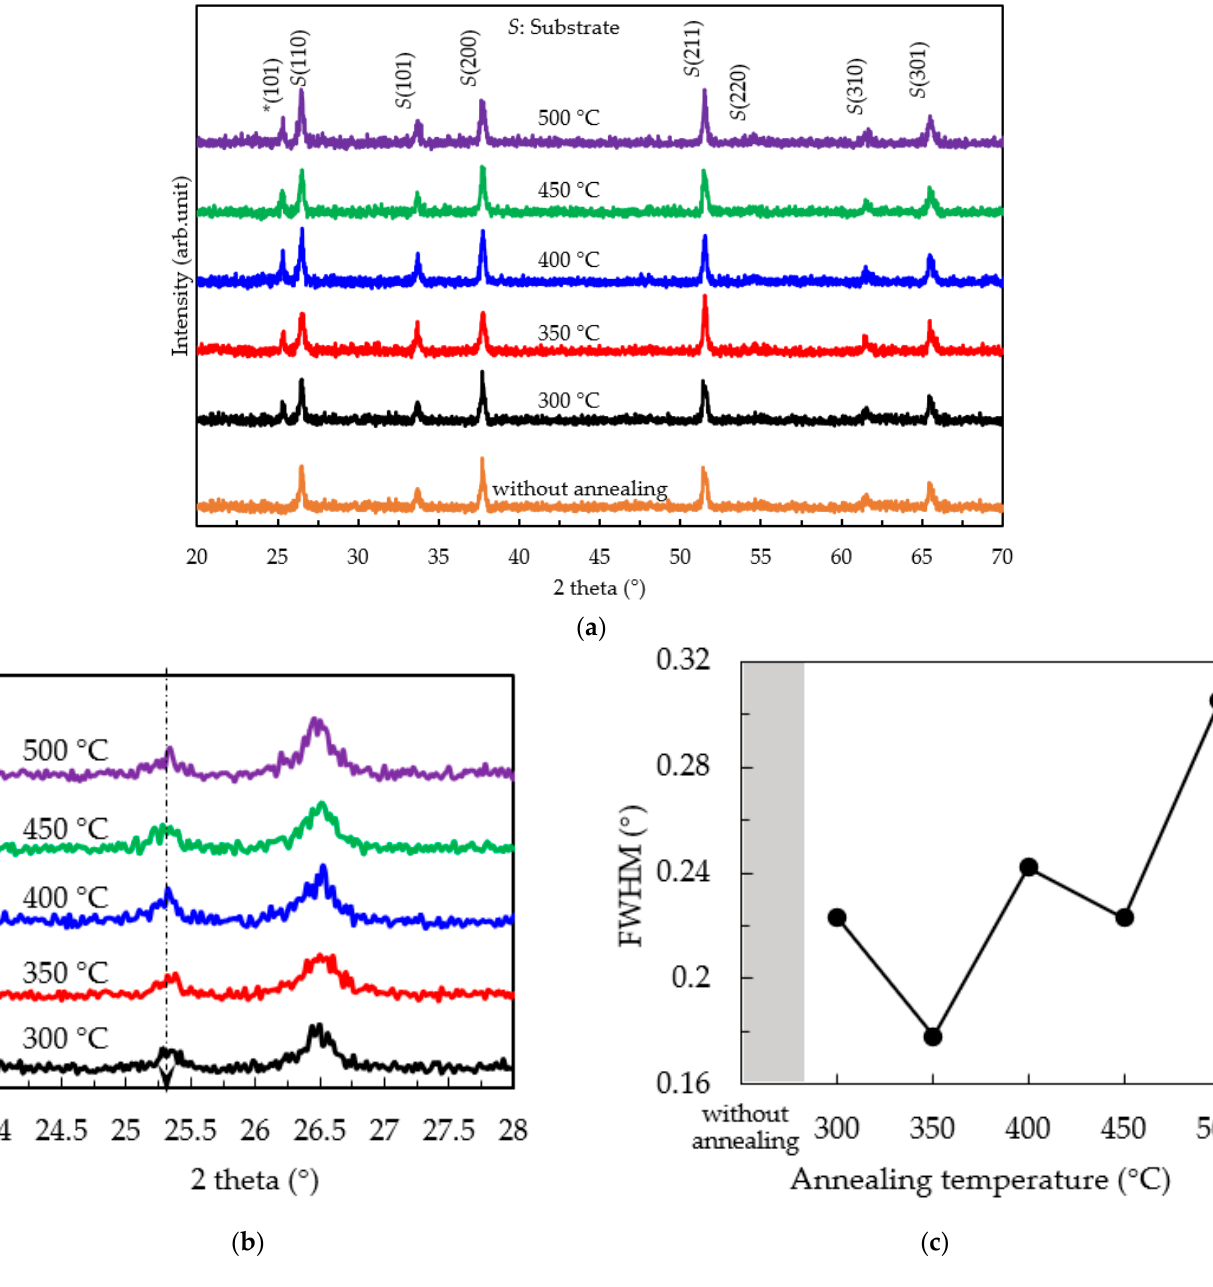
Figure 2. ( a ) The XRD patterns from 20° to 70° for the 7.5 wt%-injected TiO 2 film annealed at different temperatures from 300 to 500 °C; ( b ) the limited range of 24° to 28° for the undefined phase marked with a star, with ( c ) its variation in full width at the half maximum (FWHM) value.